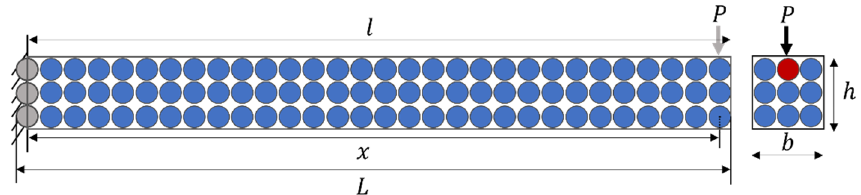
Figure 3. Particle arrangement and boundary conditions for cantilever beam deflection.